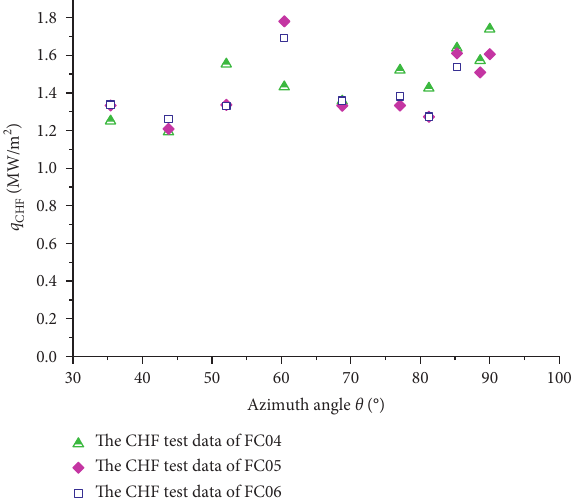
Figure 8: CHF distribution of the FC04-FC06 test conditions.